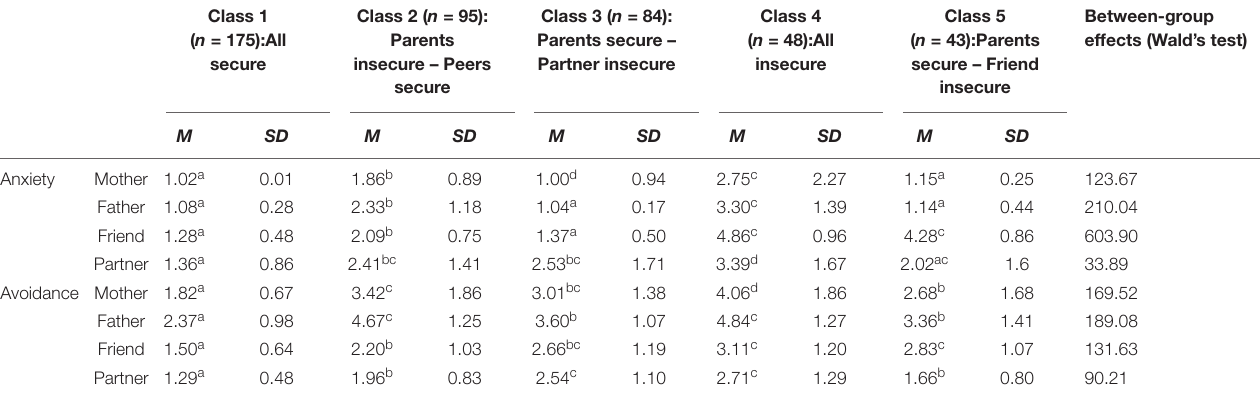
TABLE 3 | Means of indicator variables for adolescent latent attachment classes.